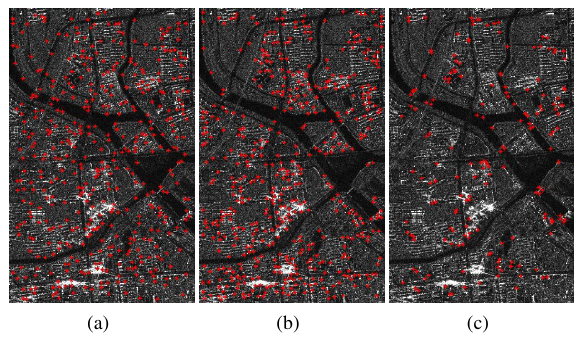
Figure 6. The detection results of three detectors on the real-world SAR image. (a) The result of our proposed method. (b) The result of SAR-FAST method. (c) The result of SAR-Harris